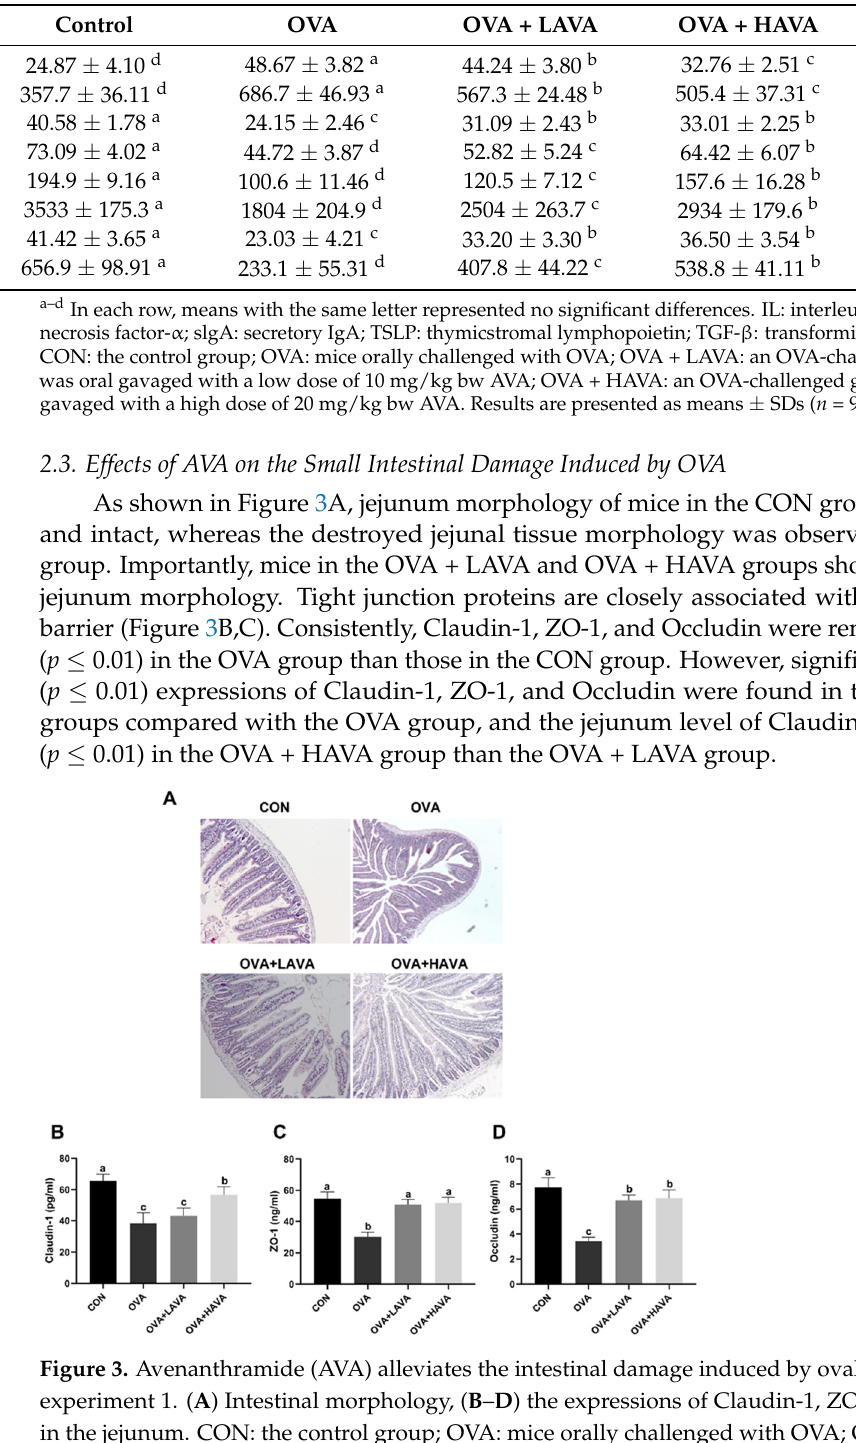
Table 1. Cytokines in the jejunum in experiment 1.